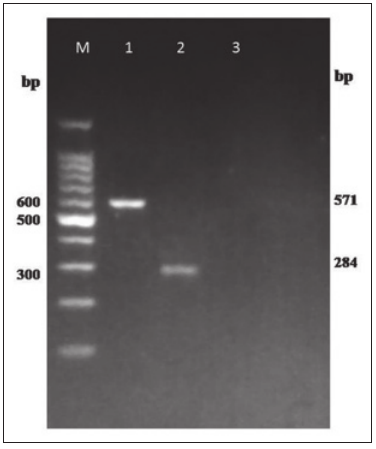
Figure-1: Polymerase chain reaction amplification of virulence genes invA and Salmonella plasmid virulence C (spv C ) of Salmonella Gallinarum isolates. Lane M: 100 bp DNA ladder, Lane 1: inv A gene (strain WBSG1), Lane 2: spvC gene (strain WBSG2), Lane 3: Negative